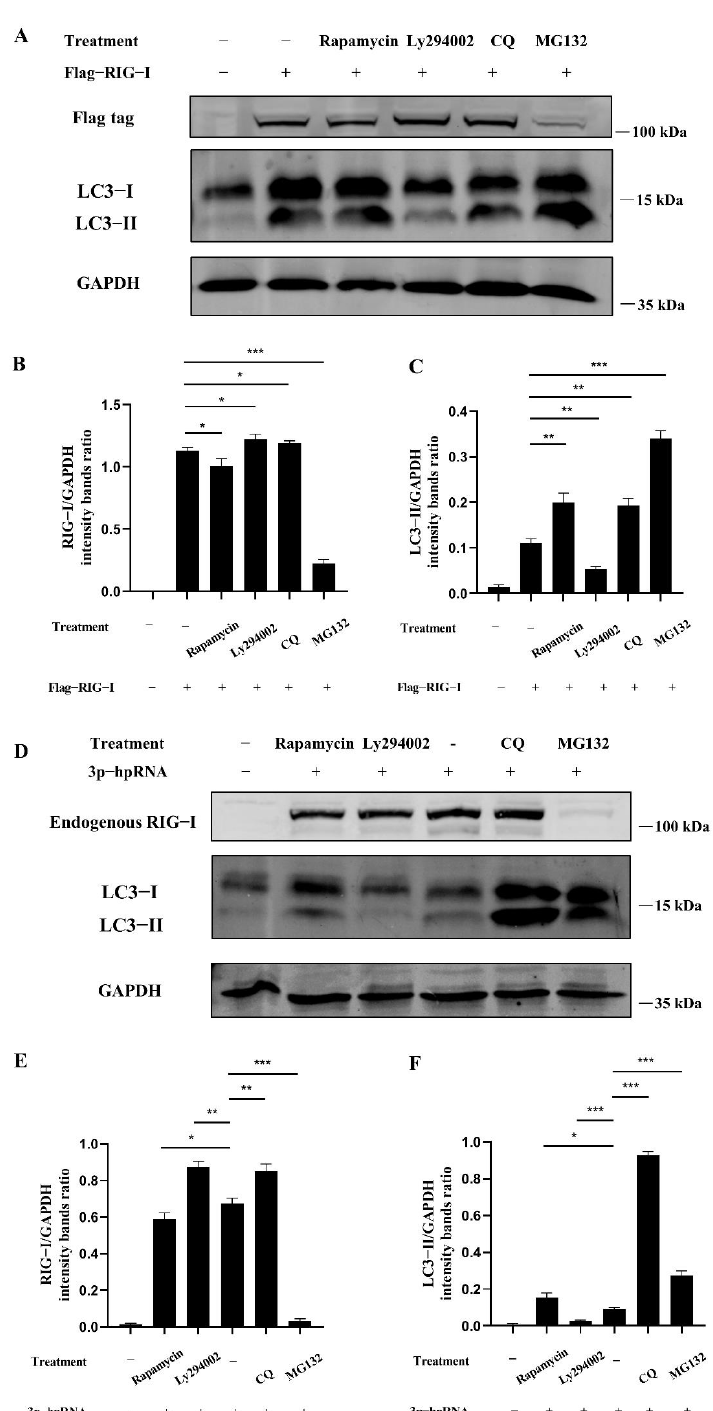
Figure 6. Autophagy regulates the signaling and expression of RIG-I. ( A ) HEK 293T cells were transfected with 2500 ng Flag-RIG-I. After 24 h transfection, cells were treated with rapamycin (1 µ M), ly294002 (20 µ M), chloroquine (50 µ M), and MG132 (20 µ M) for 12 h. ( D ) HEK 293T cells were stimulated with the 500 ng of 3p-hpRNA. After 24 h transfection, cells were treated with rapamycin (1 µ M) and ly294002 (20 µ M) for 12 h, respectively. ( B , E ) Protein band intensity of RIG-I and GAPDH were used for Western blotting quantification analysis. ( C , F ) Protein band intensity of LC3B-II and GAPDH were used for Western blotting quantification analysis. Samples were analyzed in three independent experiments ( * p < 0.05, ** p < 0.01, *** p <